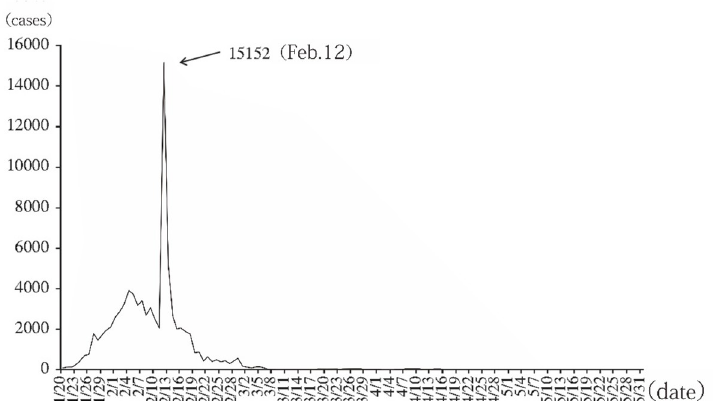
Fig 1. Daily figure of newly confirmed cases on the Chinese mainland [16]. Note: On February 12, newly confirmed cases reached 15,152 (including 13,332 cumulative clinically diagnosed cases in Hubei).